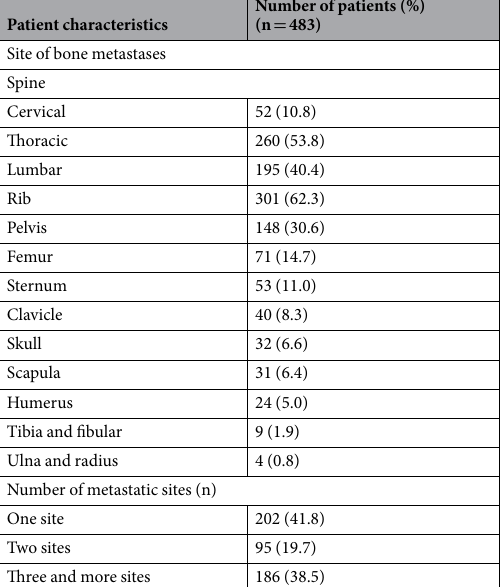
Table 3. The distribution and number of metastatic sites in patients with bone